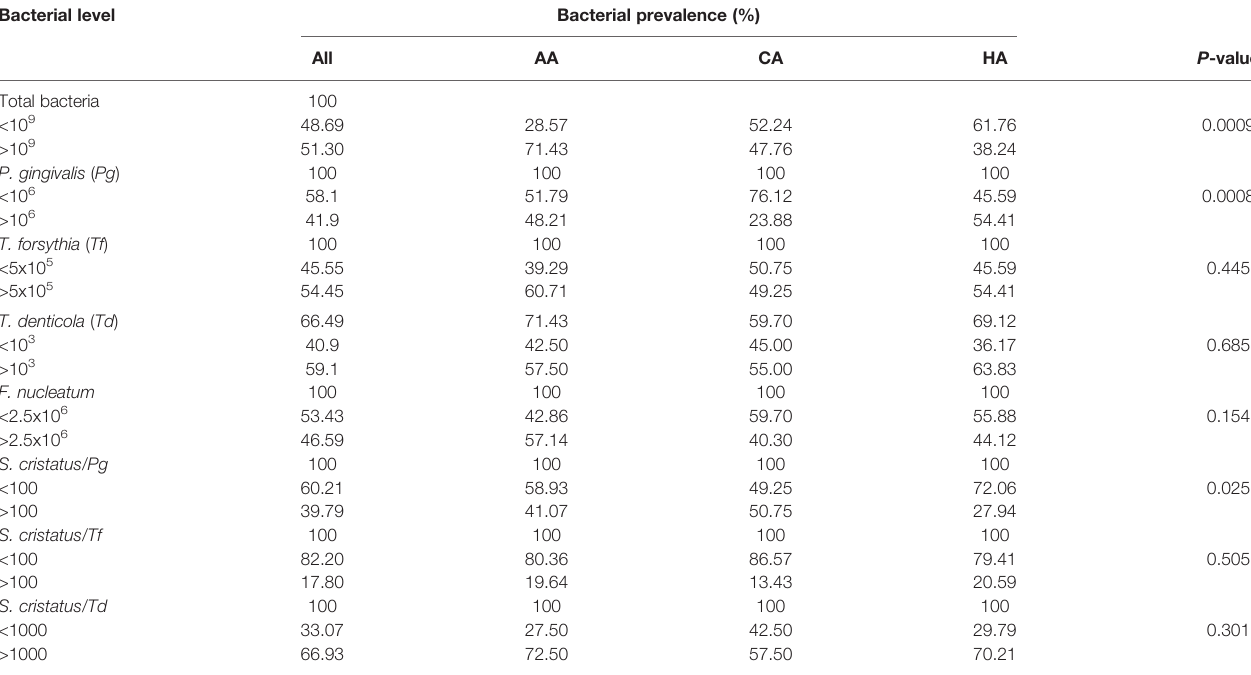
TABLE 3 | Distributions of periodontitis-associated bacteria in samples from patients of different racial/ethnic backgrounds. Bacterial level